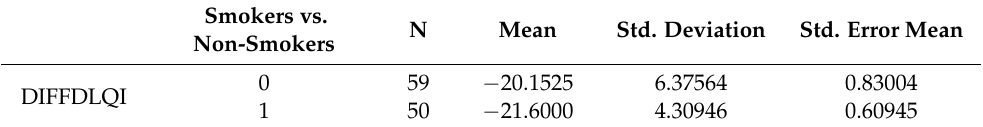
Table 2. DIFFDLQI in group statistics.